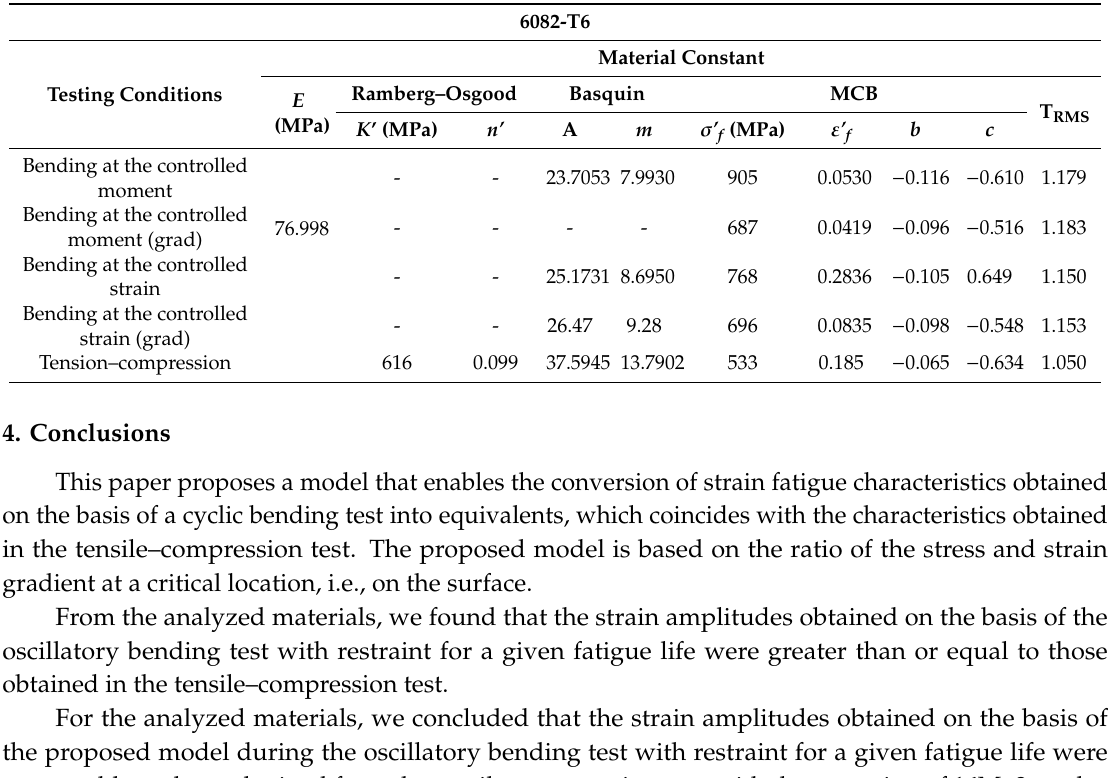
Table 9. Cyclic properties of 6082-T6 aluminum